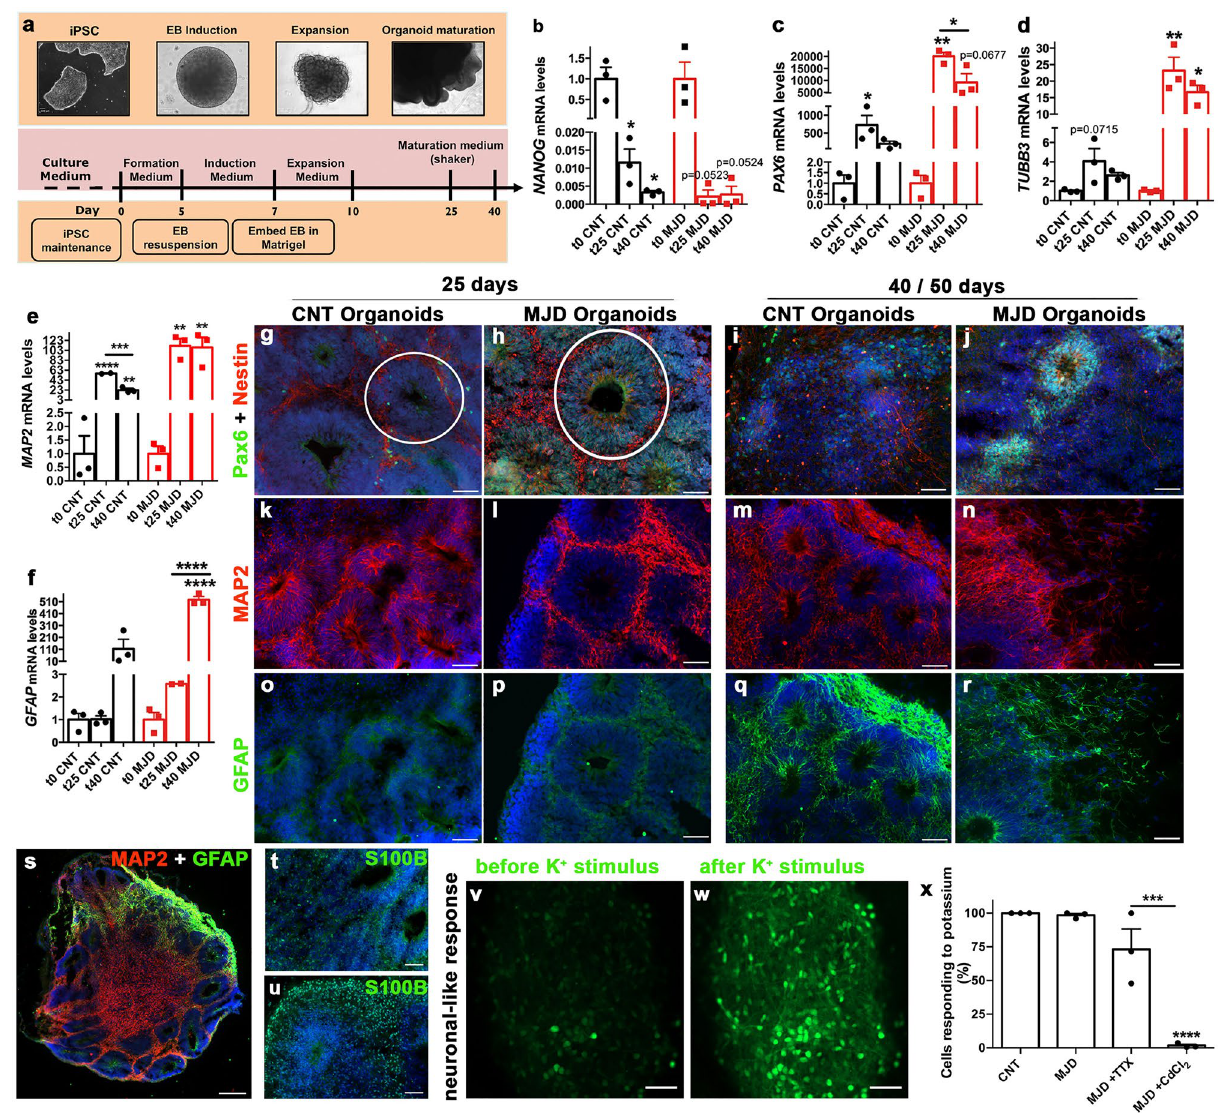
Figure 1. Control and MJD brain organoids present ventricular-like zones, neural progenitor cells, glia, and neurons. (a) Schematic representation of the brain organoid protocol used, iPSC induced pluripotent stem cells, EB embryoid body. (b–f) NANOG , PAX6 , TUBB3 , MAP2 , and GFAP mRNA levels evaluation through RT-qPCR of control (CNT) and MJD organoids at different time points (day 0, 25, and 40, respectively t0, t25, and t40) normalized for the respective t0. Data indicated that NANOG mRNA levels, a marker of pluripotency, decreases over time and the mRNA levels of neuronal ( TUBB3 and MAP2 ), glia ( GFAP ), and neuroectoderm ( PAX6 ) increase. (g–u) Immunohistochemistry evaluation of CNT and MJD organoids with 25 and 40/50 days for (g–j) Pax6 (green) and Nestin (red), ( k–n ) MAP2 (red) and (o-r) GFAP (green) expression, demonstrating the presence of these markers; white circles: ventricular-like zone. (s) MAP2 and GFAP expression and nuclear staining (DAPI: blue) revealing the presence of neuronal and glial cells surrounding ventricular regions in control organoids with 40 days. (t–u) S100B (green) expression in ( t ) control and ( u ) MJD organoids with 40/50 days. (v–x) Single-cell calcium imaging assay showing the presence of potassium firing neurons in CNT and MJD organoids with 35 days. Representative images of CNT brain organoids (v) before and (w) after potassium (K +) stimulus administration. (x) Quantification of cells responding to potassium stimulus in CNT and MJD organoids, and in MJD organoids upon inhibition of voltage-gated sodium channels with TTX (MJD + TTX) and inhibition of voltage-gated calcium channels with CdCl 2 (MJD + CdCl 2 ). Data are expressed as mean ± SEM (n: 3 independent experiments), *p < 0.05, **p < 0.01, ***p < 0.001, ****p < 0.0001 ( b–f : comparison established with the correspondent t0 or between the conditions indicated by the lines),